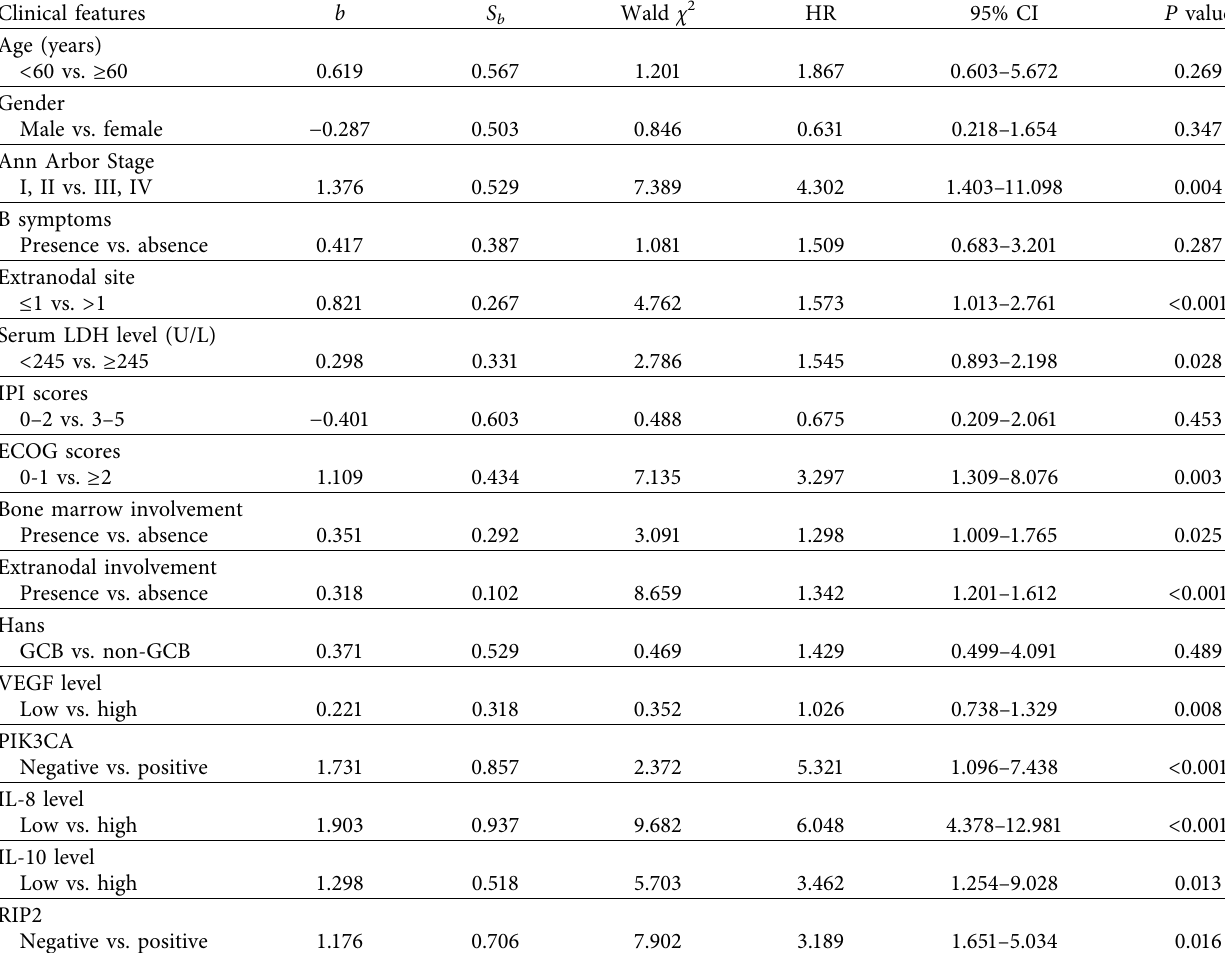
Table 2: Regression analysis of the univariate Cox proportional hazard model for overall